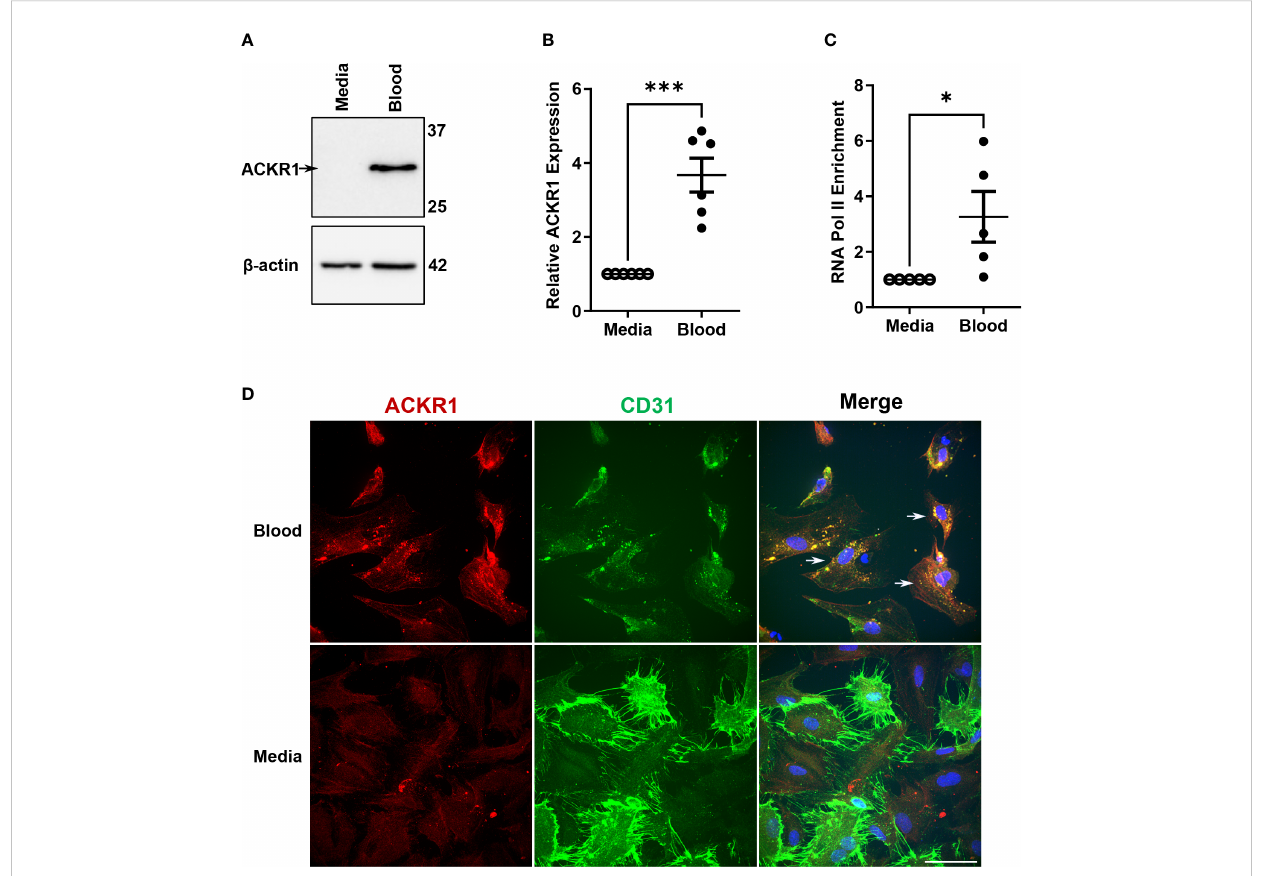
FIGURE 1 Incubation with blood induces ACKR1 mRNA and protein in primary human lung microvascular endothelial cells. (A) Immunoblotting for ACKR1 using the Ab58965 antibody in cells incubated with blood or complete media for 24 hours. (B) qPCR for ACKR1 mRNA under the same conditions (***p<0.001). (C) Chromatin immunoprecipitation assay using antibody to RNA polymerase II or IgG control and primers for the ACKR1 coding region after treatment of cells as in A) (*p<0.05). (D) Immunostaining of endothelial cells for ACKR1 (red) after 6 hours incubation with blood; the endothelial membrane protein CD31 is stained in green. Note increased ACKR1 expression in the blood-exposed cells that are positive for CD31 (white arrows in merged